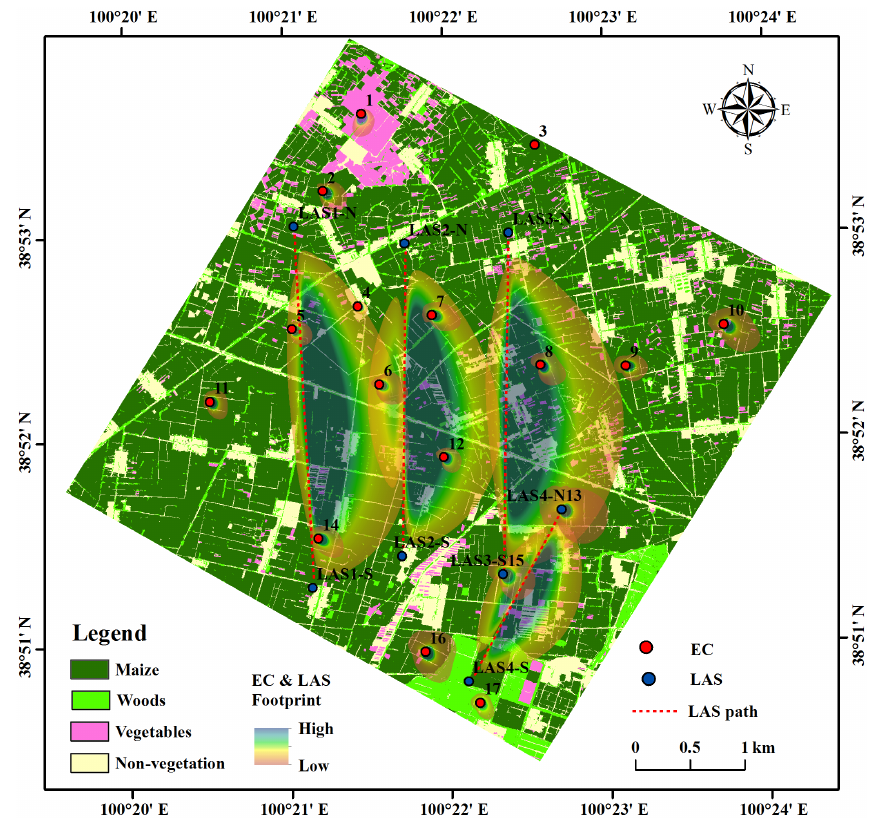
Figure 1. The land-cover map of the kernel experiment area of HiWATER 2012 and the daytime-averaged (8:30–15:30, BST) footprint distribution for EC and LAS (90% flux contribution) for 29–30 June